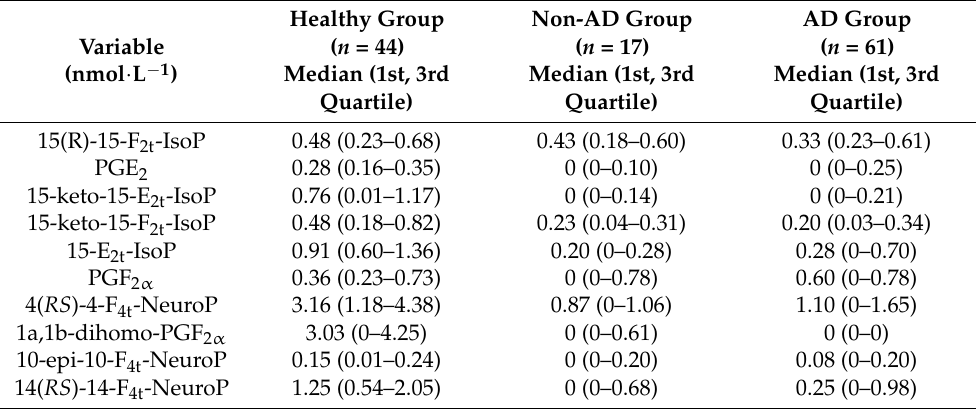
Table 2. Plasma levels of lipid peroxidation compounds.